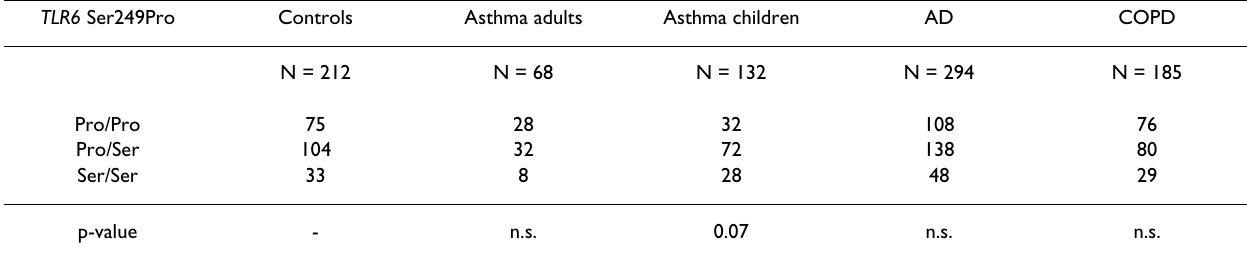
Table 2: Genotype frequencies of the TLR6 Ser249Pro polymorphism in the case and control groups. TLR6